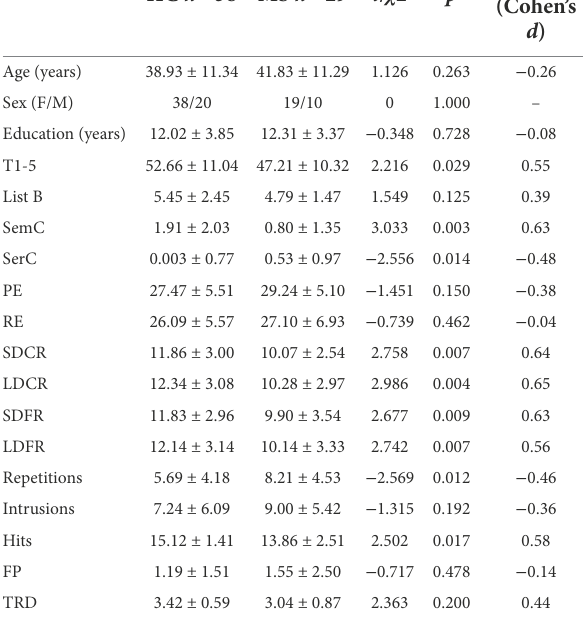
TABLE 8 Comparison of CVLT-II indices between participants with MS and matched healthy